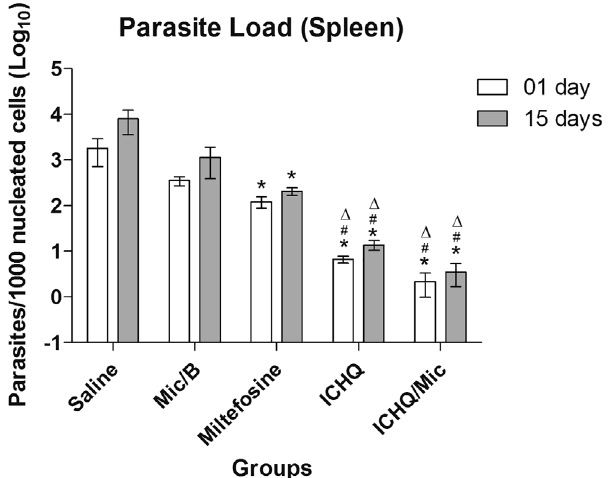
Figure 7. Splenic parasitism evaluated by RT-PCR. Splenic para- sitism was also evaluated by RT-PCR, one and 15 days after treatment. Results were converted into number of parasites (in log) per nucleated cell (multiplied by one thousand to facilitate visual- ization). Bars indicate the mean ± standard deviation of the groups. (*), (#) and ( D ) indicate statistically signi fi cant differences in comparison to the saline, Mic/B and miltefosine groups, respectively ( p <